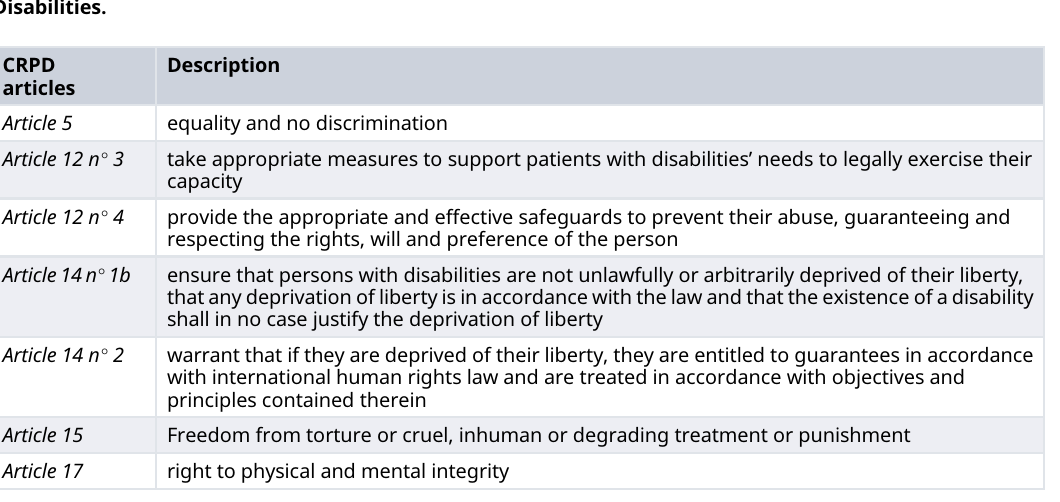
Table 2. Significant article ideas from the United Nations Convention on the rights of Persons with Disabilities.